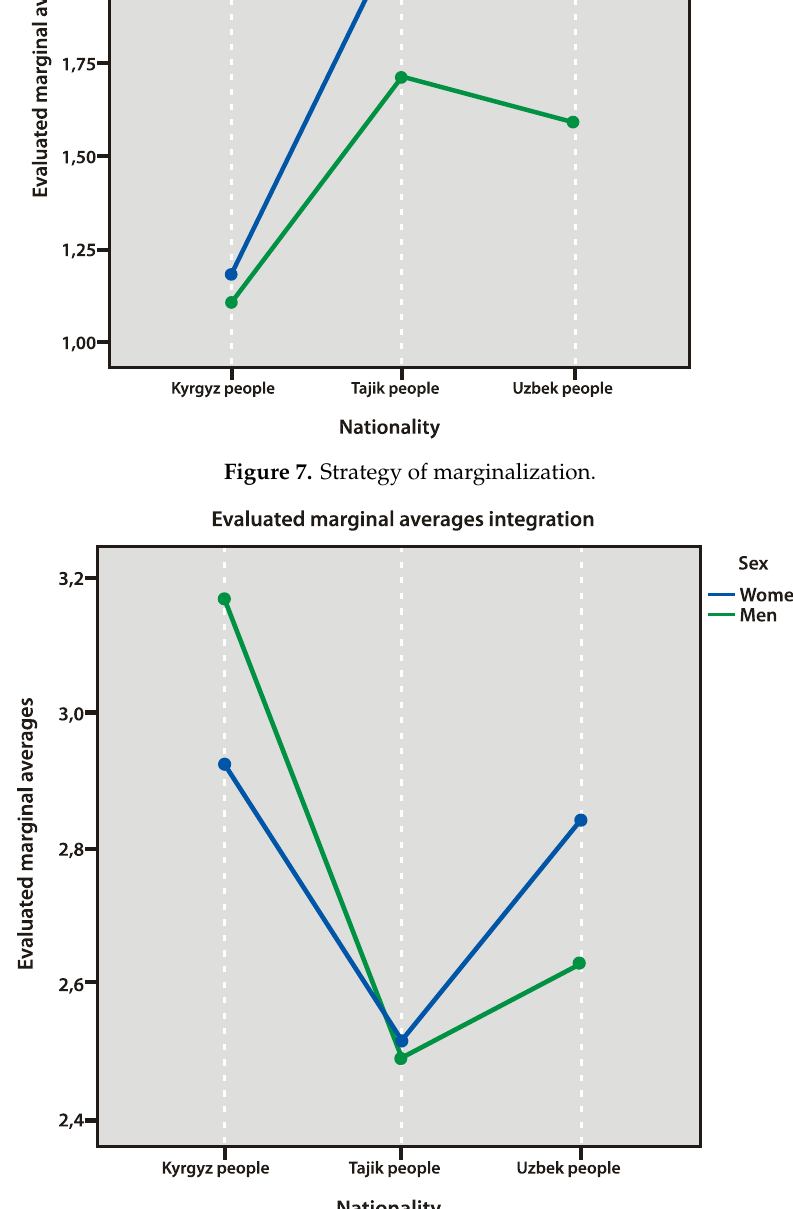
Figure 8. Strategy of integration.